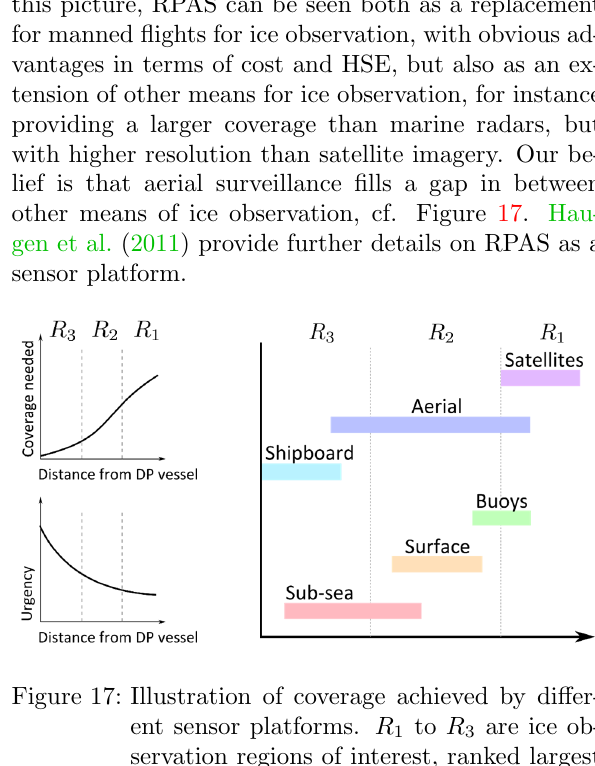
Figure 16: Ice topography drifting at speed v , and an estimation setup with nodes separated λ s [m] along the x -axis in which we mea- sure and estimate the ice draft. The